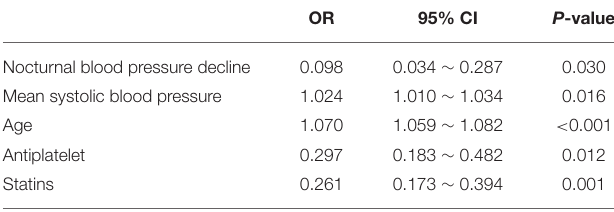
TABLE 3 | The multivariate logistic regression analysis between lacunes and control.